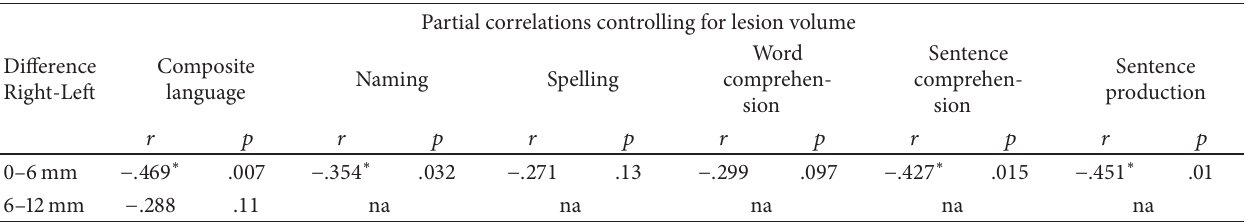
Table 5: Partial correlations, controlling for lesion volume, between perilesional perfusion and language ability for 35 participants with aphasia.